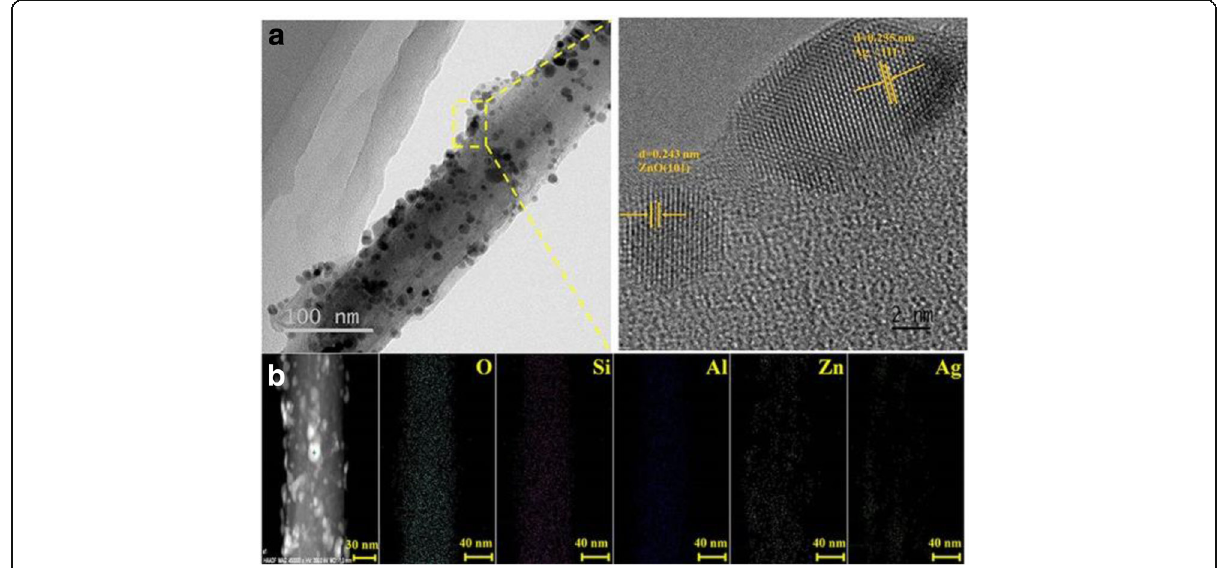
Fig. 3 a TEM images and the corresponding HRTEM of Ag-ZnO/HNTs and b EDS elemental mappings of O, Si, Al, Zn, and Ag